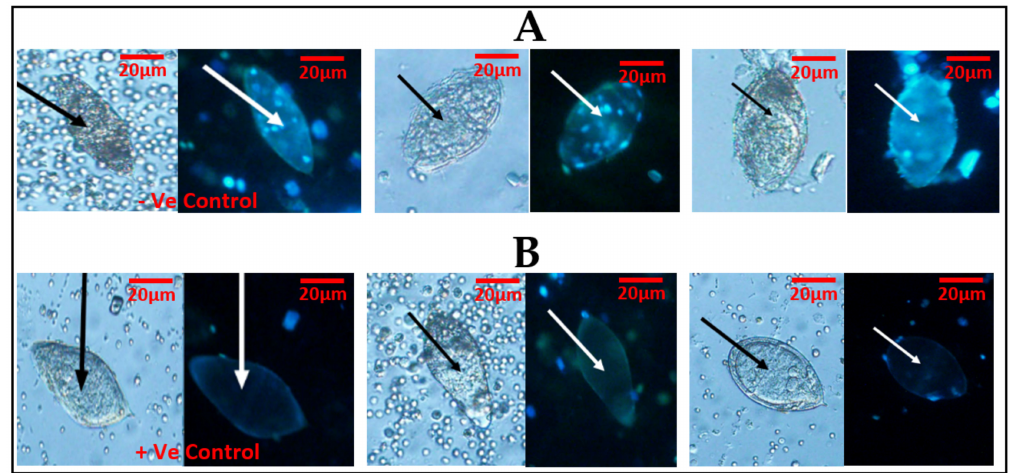
Figure 2. Schistosoma haematobium ova was observed under × 20 objective lens using light microscopy first, followed by fluorescent microscopy, with the cell stain (Hoechst 33258): ( A ) two eggs in light microscopy followed by fluorescent microscopy using Hoechst 33258 and showing fluorescence (blue), indicative of dead eggs. ( B ) A lane demonstrating two eggs in light microscopy, followed by fluorescent microscopy using Hoechst 33258 and demonstrating no fluorescence, indicative of live eggs. The first slides of ( A ) and ( B ) show –Ve (negative) and + Ve (positive) controls,